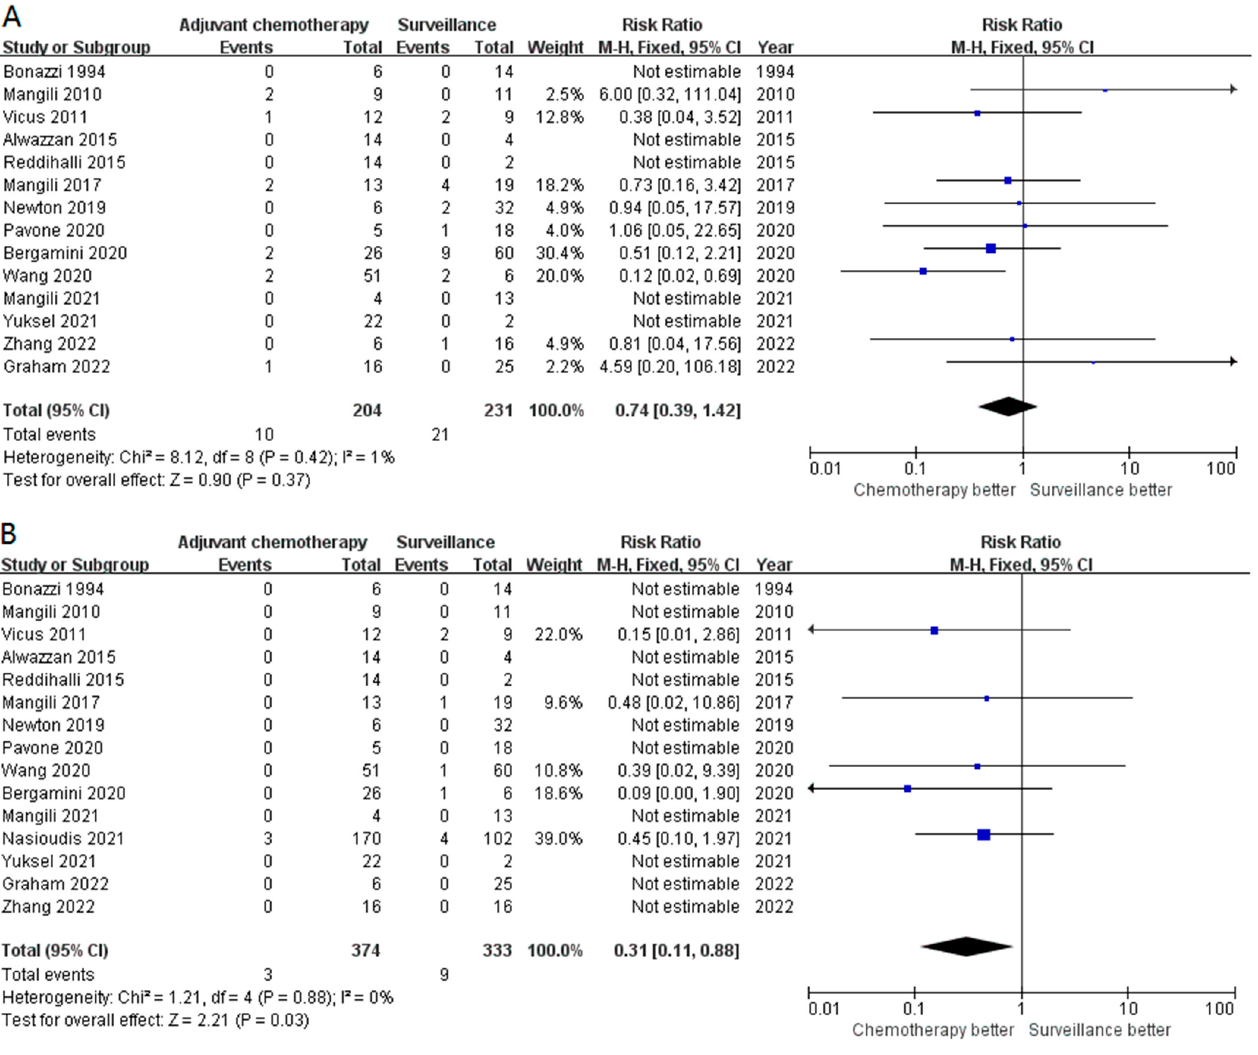
Figure 2. The forest plot demonstrates the impact of adjuvant chemotherapy in stage I POIT in the overall population. ( A ) Impact of adjuvant chemotherapy in disease recurrence; ( B ) surveillance significantly improved the DSS.